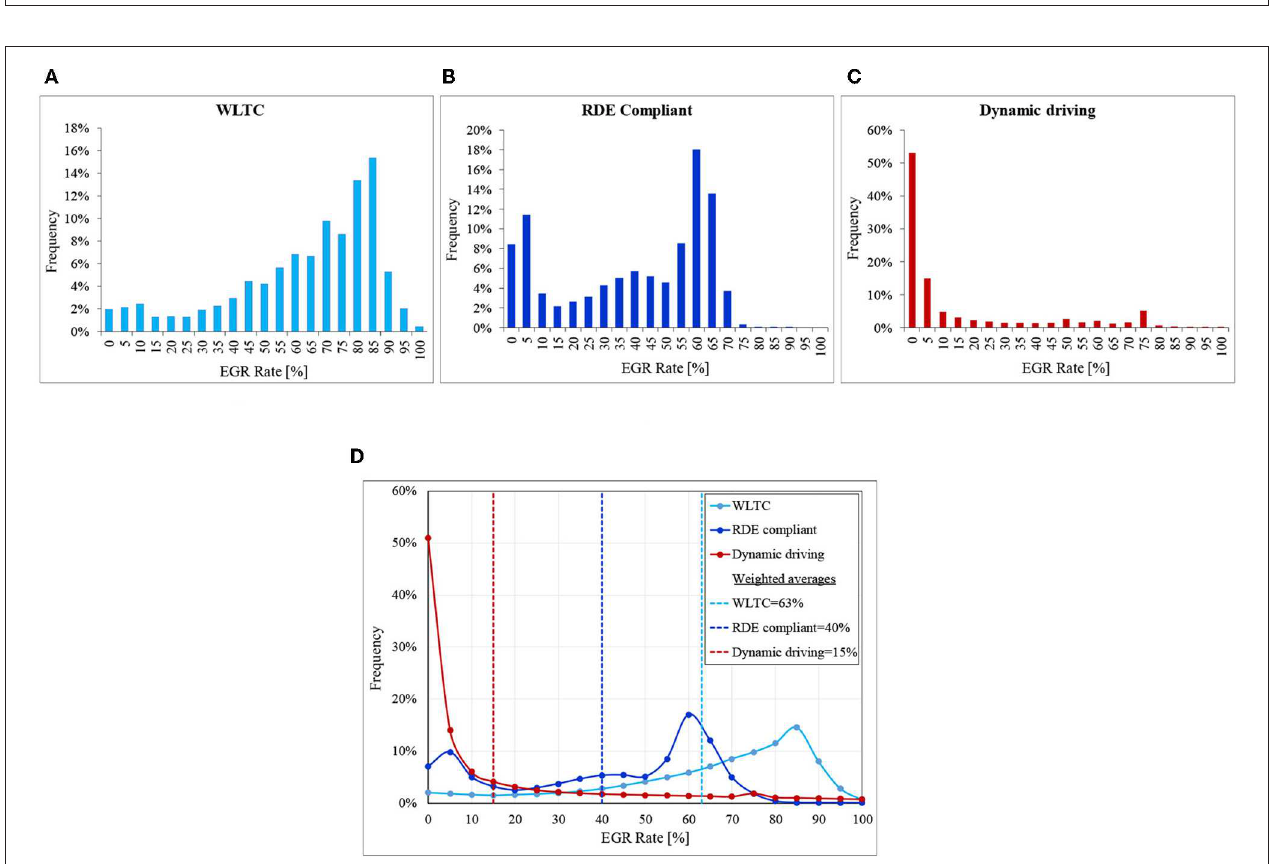
Frontiers in Mechanical Engineering |